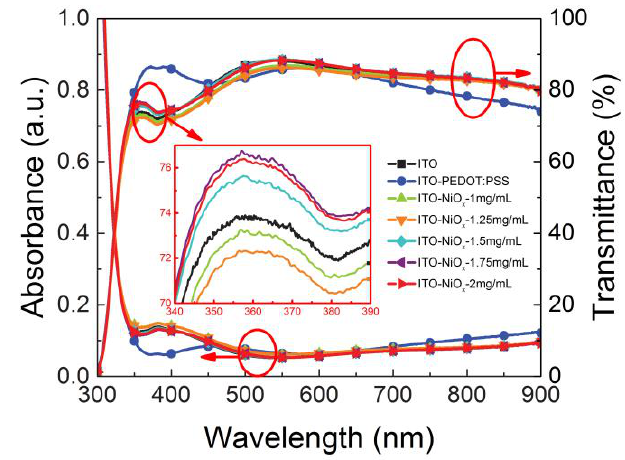
Figure 4. Optical absorption and transmittance spectra of ITO, ITO/PEDOT:PSS and ITO/NiO x (with different concentration) substrates, the inset is the local enlarged image of 340–390 nm.